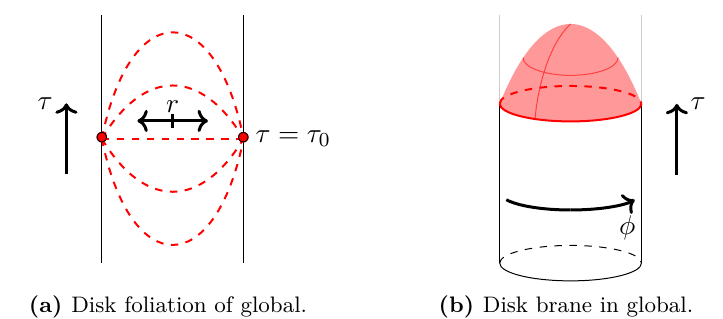
Figure 20. (a) A transverse slice of the disk foliation of Euclidean pure AdS d +1 in global co- ordinates. τ increases upward while r increases outward from the central axis. (b) The bulk configuration obtained by selecting a leaf of the disk foliation as an end-of-the-world KR brane (in red), with all transverse spherical coordinates fixed except for the periodic angle φ . We excise the part of the bulk “above” the